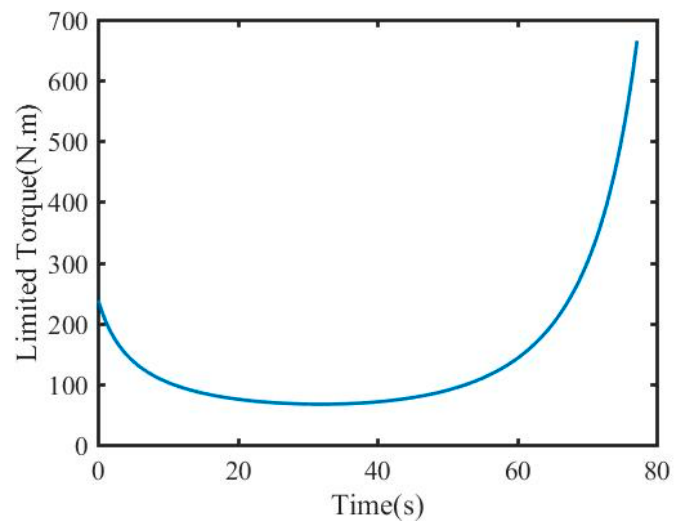
Figure 7. The simulation result of working process of VC.